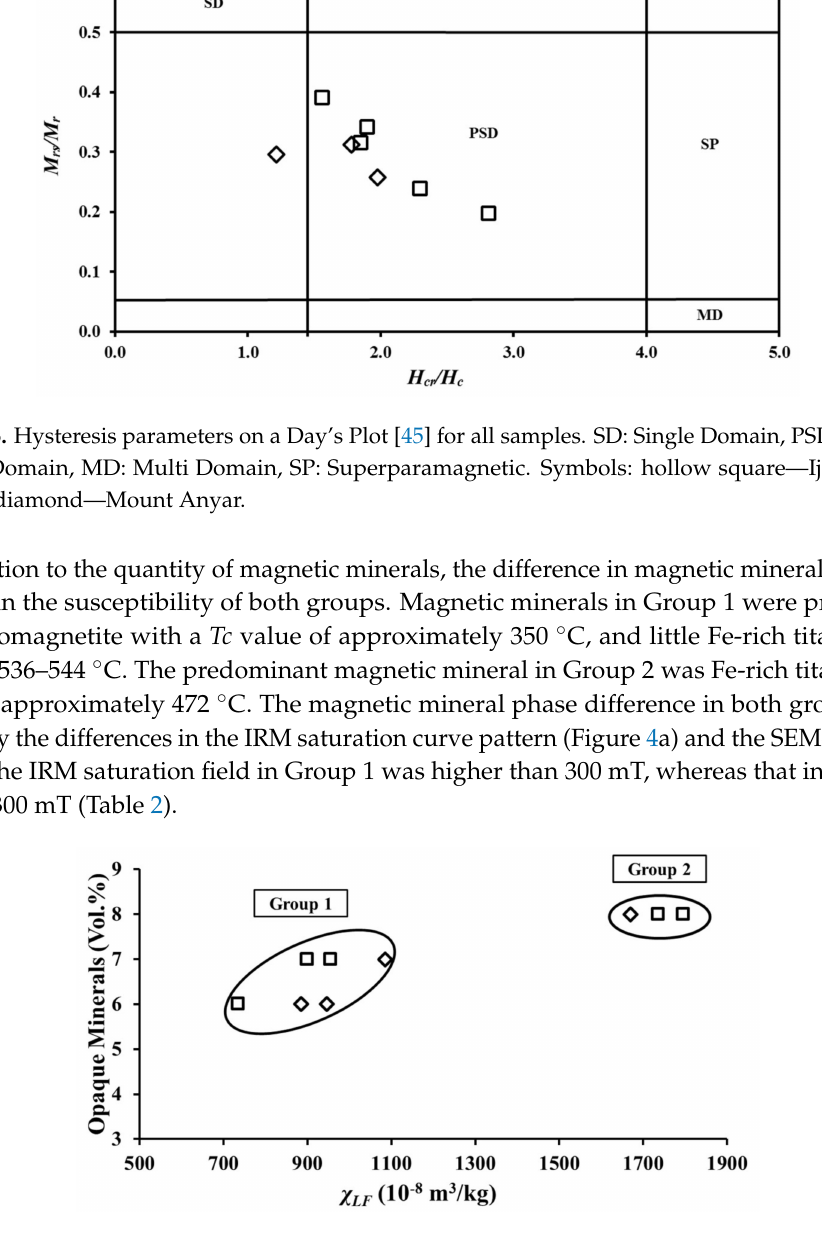
Figure 7. Plot between the percentage of opaque minerals with low frequency susceptibility in samples from Ijen Crater (hollow square) and Mount Anyar (hollow diamond) (modified from Pratama et al.